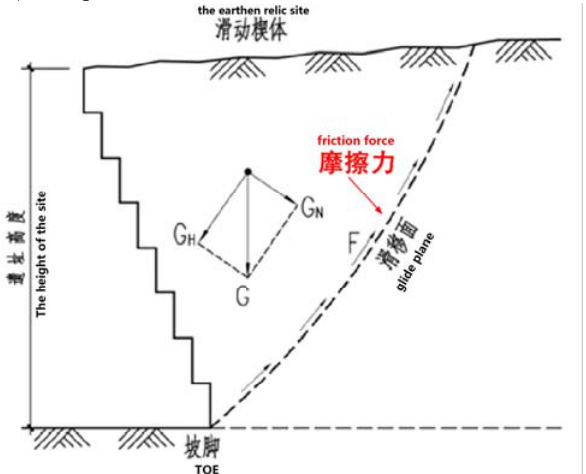
Figure 8.The analysis chart of structural